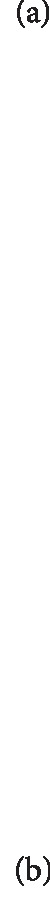
The ameliorative effect of KXS on AD rat memory and learning impairment. KXS significantly shortened the escape latency and swimming distances (a) of rats bearing cognition impairment compared with those treated with a monotreatment of GR, PR, PO, and AT. KXS prolonged the time (b), swimming distance (c), and platform crossings (d) to find the removal platform in the target quadrant. Treatment with KXS resulted in the high expression of NeuN (e and f) and the activity of AChE (g) in the hippocampus. KXS did not cause loss of body weight, suggesting that KXS might probably not cause severe toxicity (h). The column diagrams marked by different letters were significant to each other at the 0.05 level according to Duncan's multiple range test. Values were mean ± SE (n = 6), scale bar = 20 μm.